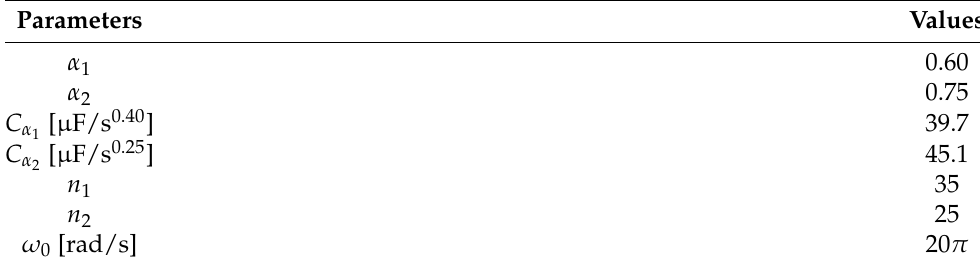
Table 1. Parameters of the designed ladder circuits.